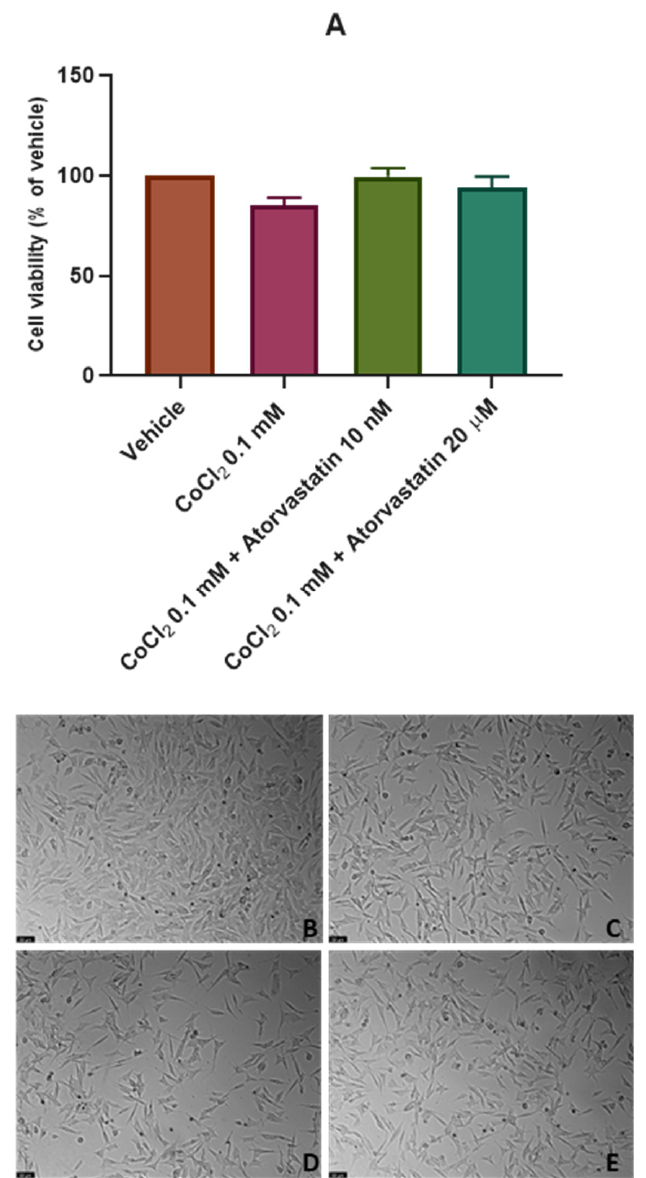
Figure 5. Effect of ( A ) CoCl 2 0.1 mM, CoCl 2 0.1 mM + atorvastatin 10 nM , and CoCl 2 0.1 mM + atorvastatin 20 µM in SH-SY5Y cellular viability (24 h) obtained by MTT assay, and representative images (100 × total magnification) of these cells after incubation with ( B ) vehicle (sterilized water 2%/DMSO 0.2%), ( C ) CoCl 2 0.1 mM, ( D ) CoCl 2 0.1 mM + atorvastatin 10 nM, and ( E ) CoCl 2 0.1 mM + atorvastatin 20 µ M, after 24 h. Cell viability results are expressed as the percentage of the vehicle (100%).